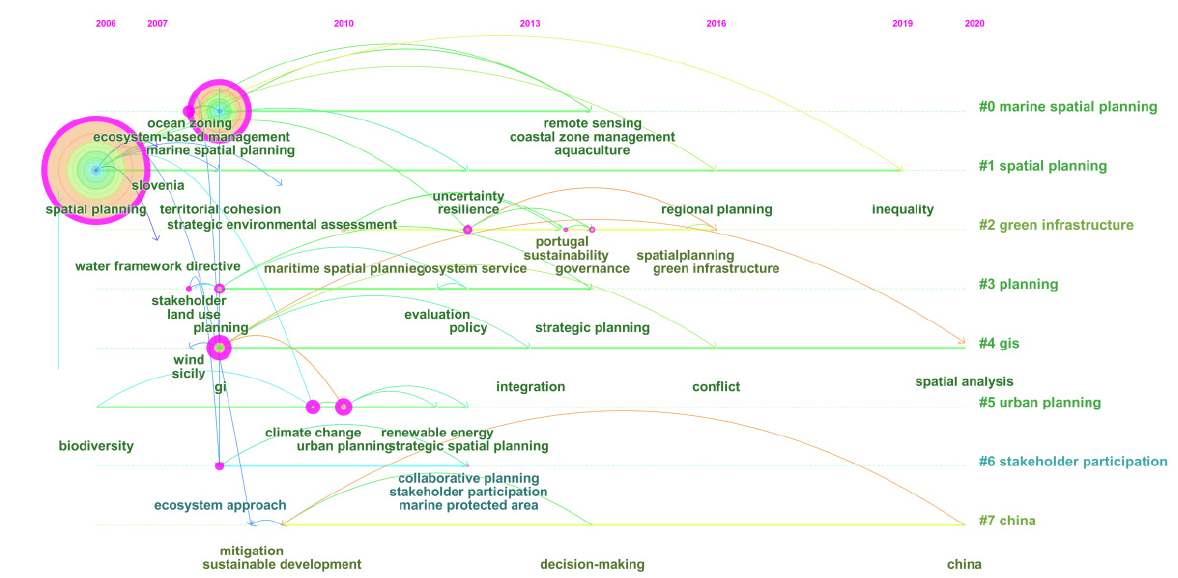
Figure 10. Visualization of the timeline (WOSCC).